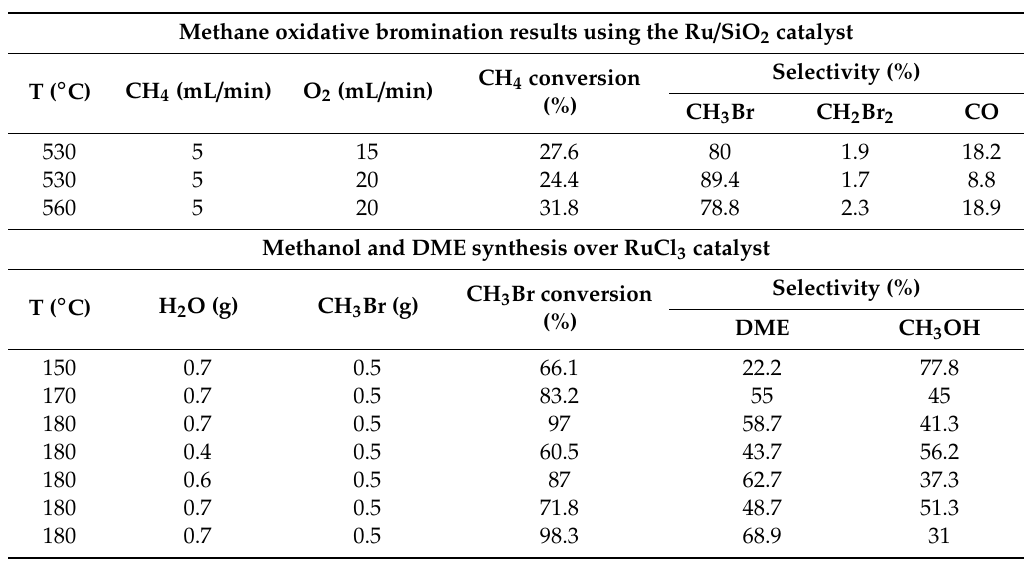
Figure 5. Products of methane bromination and coupling over Ca/ZSM-5 at different temperatures. Carbon numbers 1–4 are predominantly olefins (with trace amounts of alkanes), while 5 and 6 are a mixture of alkanes and alkenes. Reproduced with permission from [74]. Table 1. Conversions and selectivities of both stages of the DME (dimethyl ether) synthesis via bromination. Reproduced with permission from [77].